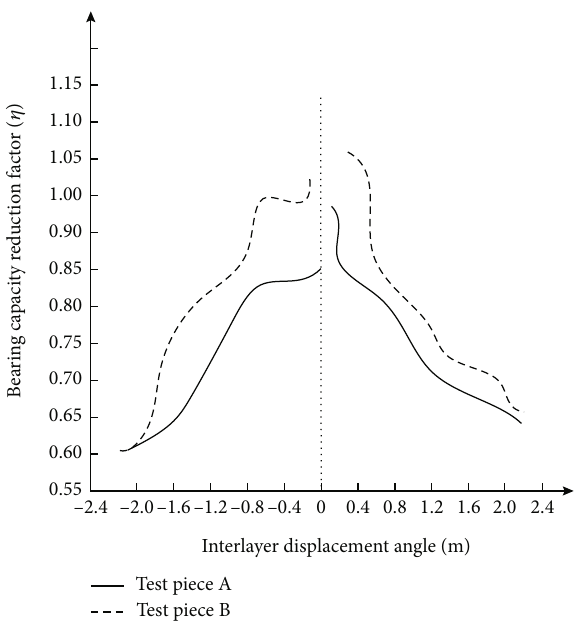
Figure 5: Strength degradation